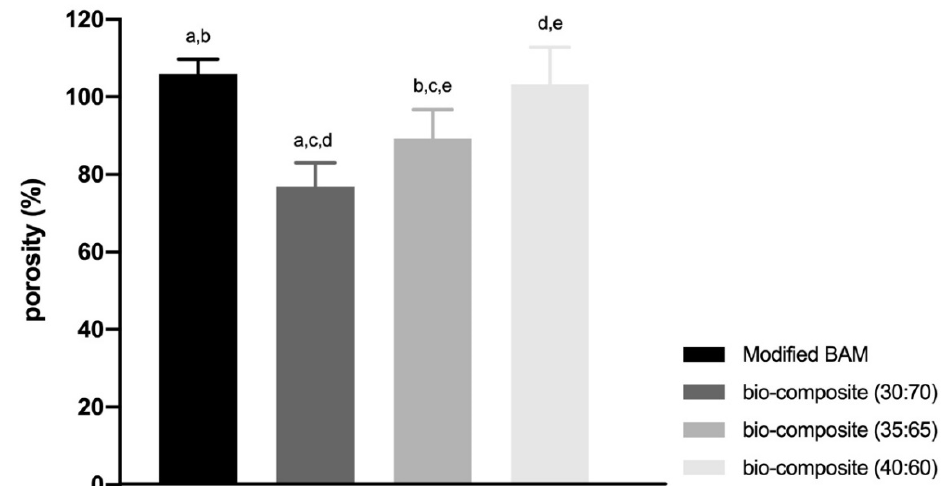
Figure 5. The result of porosity percentage of all types of bio-composite and modified BAM. (a–e means significant difference in each group with the Gomes Howell test with p -value as p < 0.01).